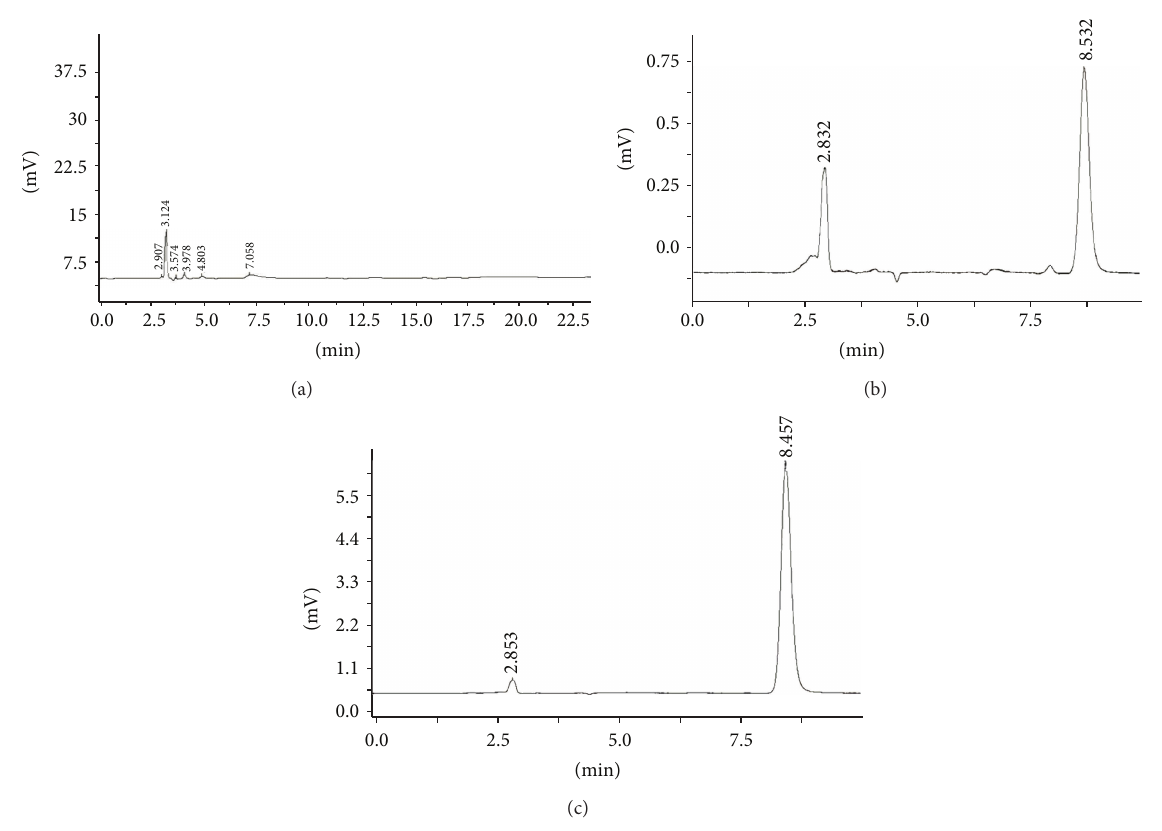
Figure 5: HPLC chromatogram of blank cubosome (a), standard sinomenine (b), and sinomenine cubosome (c).